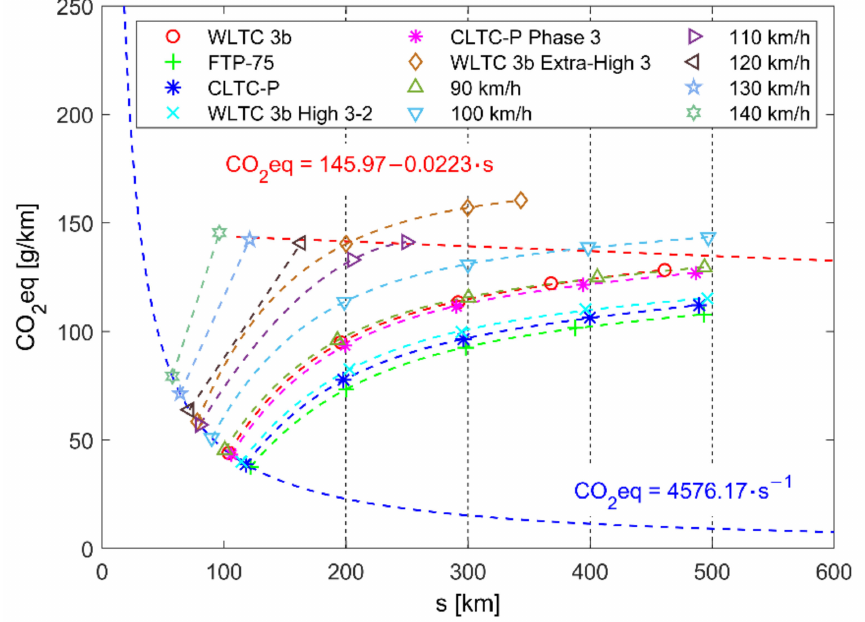
Figure A11. Combined CO 2 eq emission, due to EREV operation and electricity production (EU-27), in various driving conditions. Note that the blue approximation line (BEV mode) and the red approximation line (maximal range) are obtained for constant speed driving results from the range of 90–140 km/h. Vehicle mass is equal to 2100